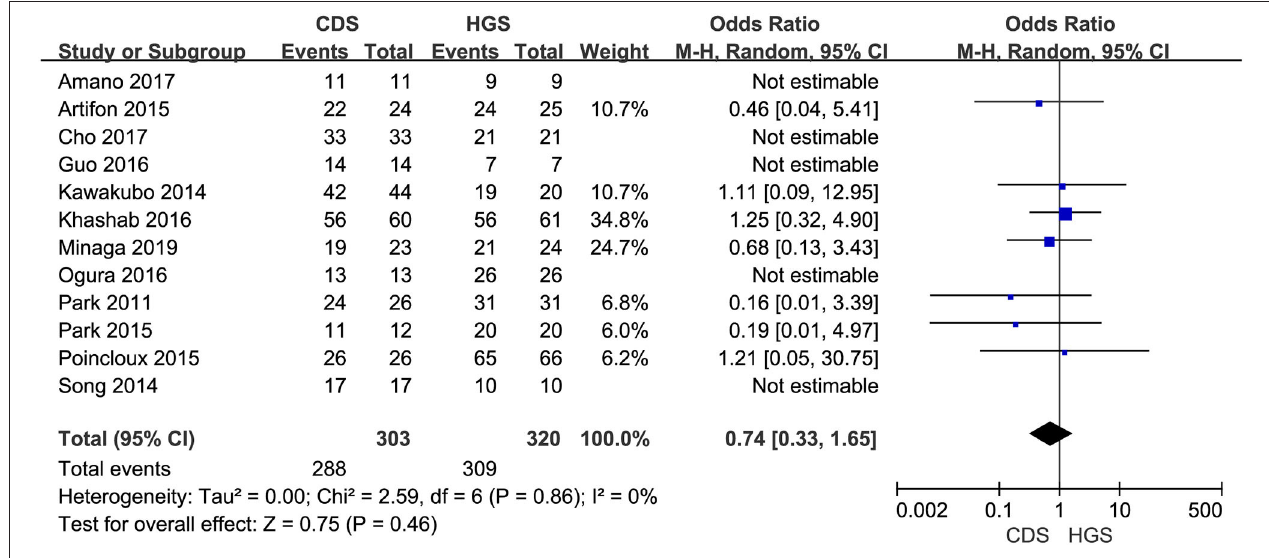
FIGURE 2 | Forest plot of technical success between EUS-CDS and EUS-HGS.